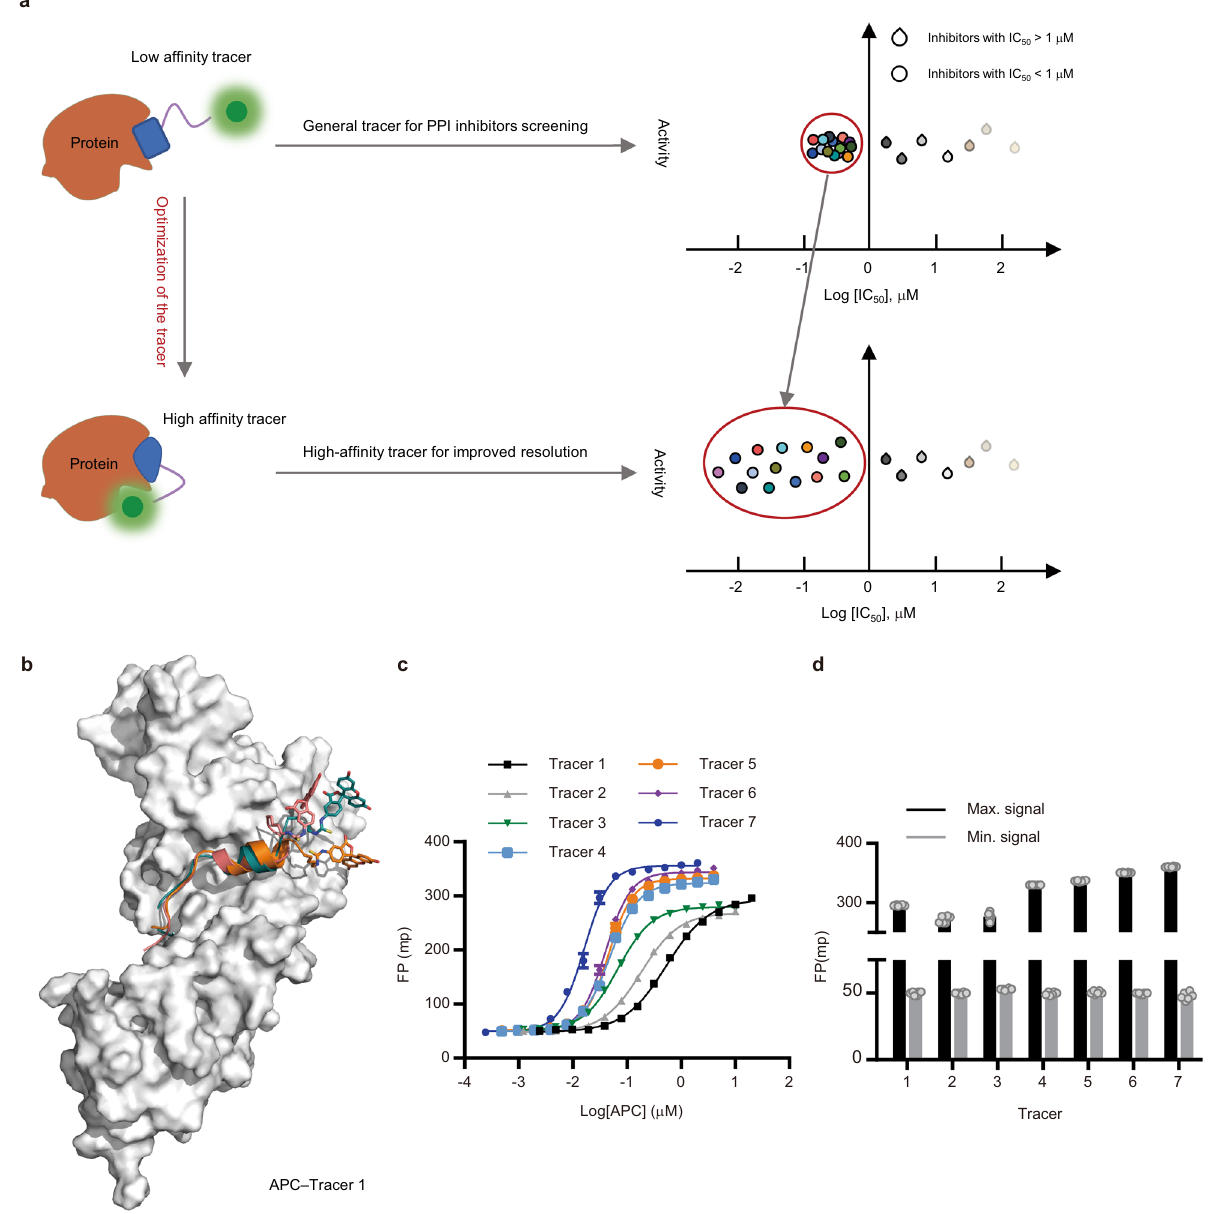
Fig. 1| OptimizationoftheFPtracer toimprovetheresolutionoftheFPassay. a SchematicillustrationoftheresolutionoftheAPC – Asefinhibitorscreeningassay using tracer 1 and tracer 7. FP assays using tracer 1 were unable to be used to discriminate inhibitors with IC 50 values < 1 μ M. FP assays using tracer 7 could be used to clearly distinguish inhibitors with IC 50 values < 1 μ M. b Three signi fi cant bindingconformationsoftracer1toAPCbymoleculardynamics(MD)simulations. Pink:binding conformation oftracer 1 to APCat36ns; Blue:binding conformation